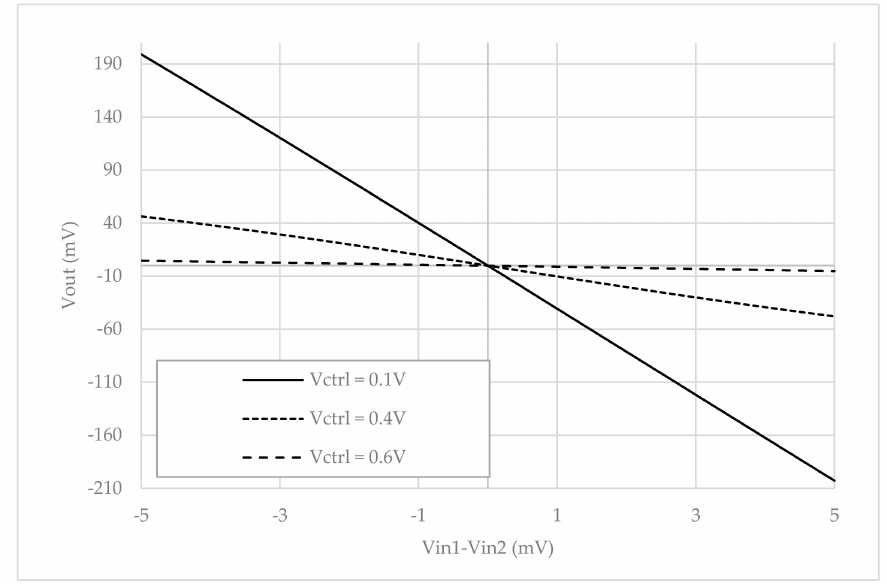
Figure 9. DC performances of the amplifier at various gain